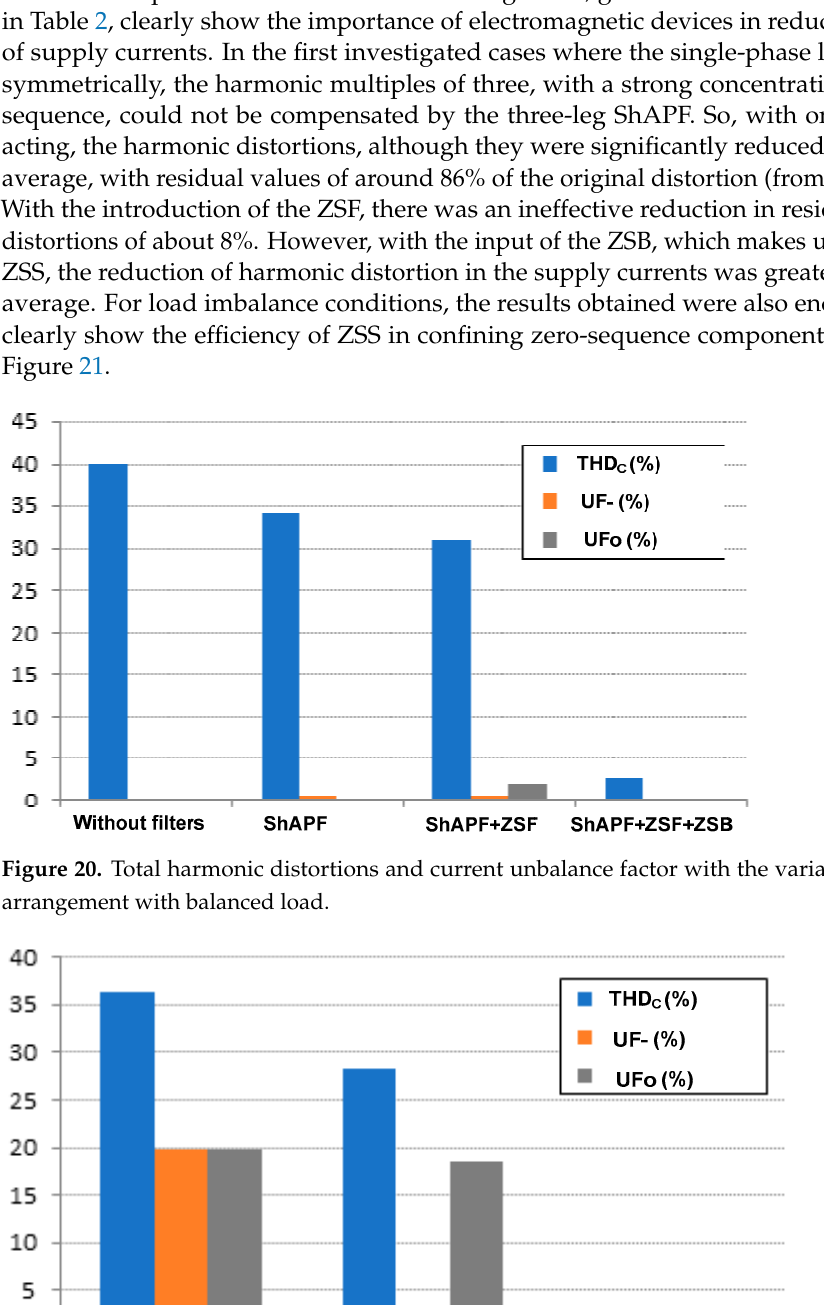
Figure 21. Total harmonic distortions and current unbalance factor with the variation of the filter arrangement with unbalanced